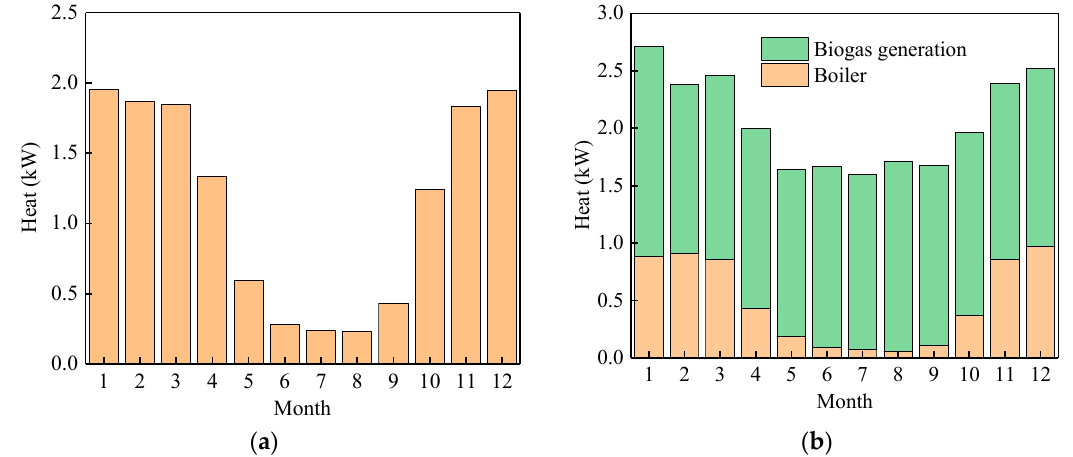
Figure 7. The simulated heat output on a monthly basis: ( a ) boiler only and ( b ) biogas generator and